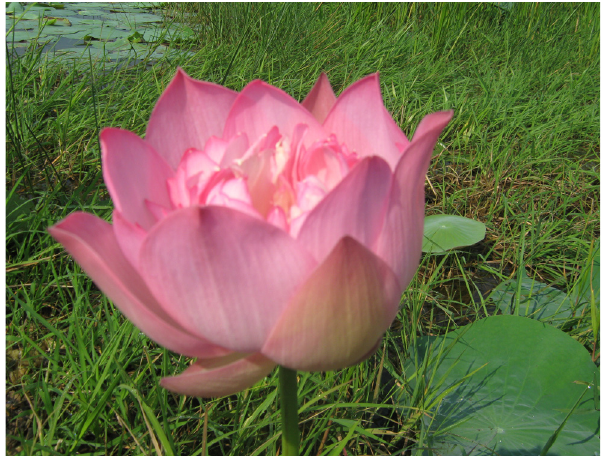
Fig. 1. Flowering twig of Nelumbo nucifera Gaertner ( Nelumbo- naceae )